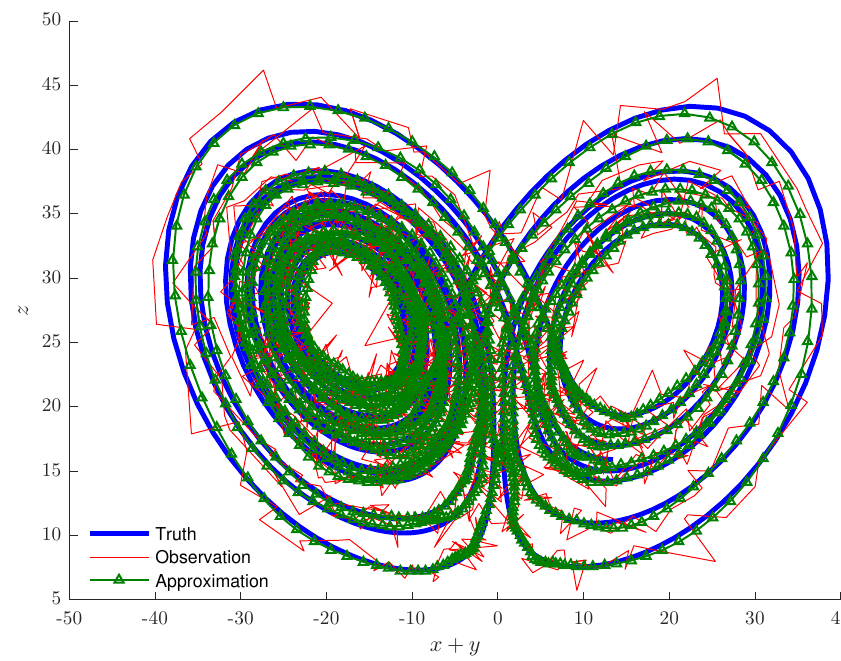
Figure 11. Chaotic Lorenz attractor (blue line), noisy observations (red line) and the tracking technique results (green